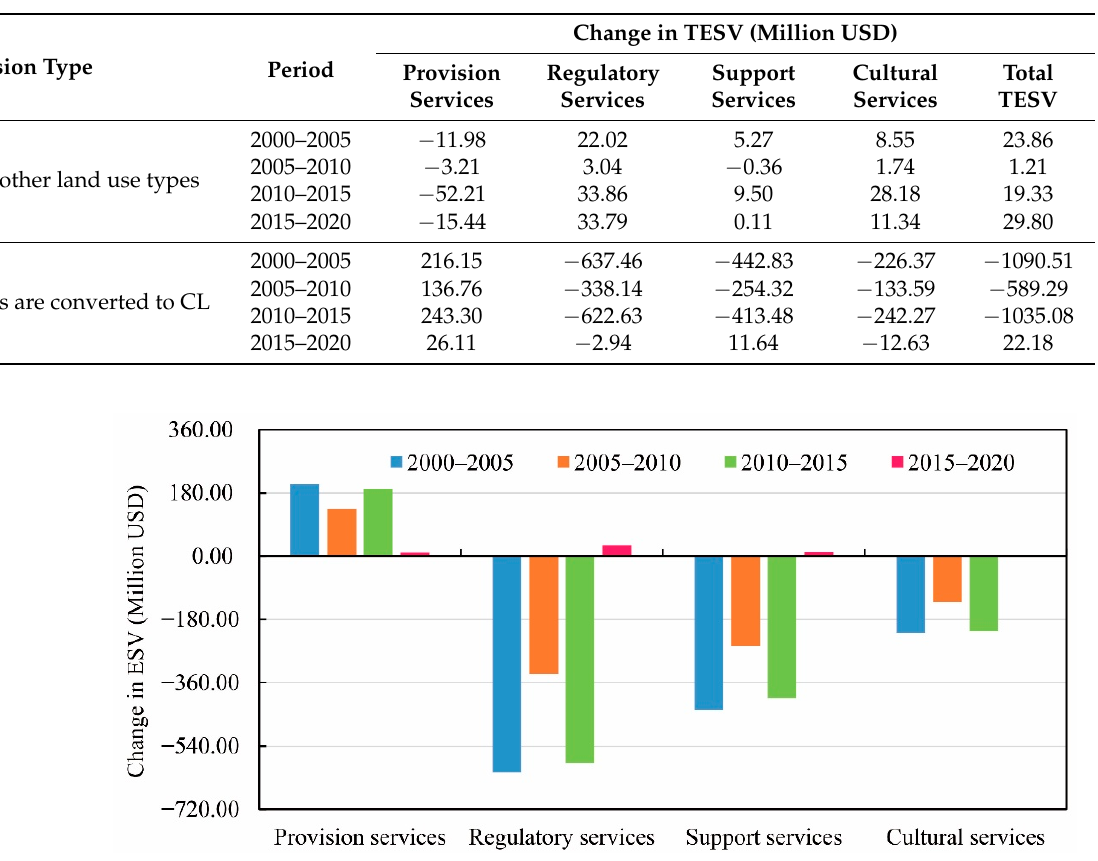
Table 8. Changes in the TESV caused by the conversion of cropland in Xinjiang during 2000–2020.